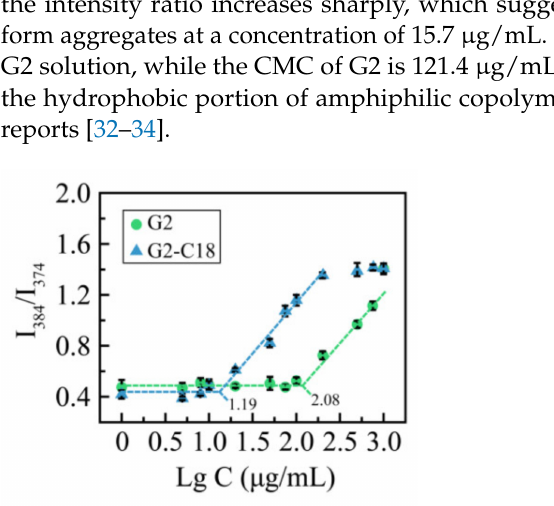
Figure 3. Intensity ratio I 384 /I 374 curves as a function of G2 and G2-C18